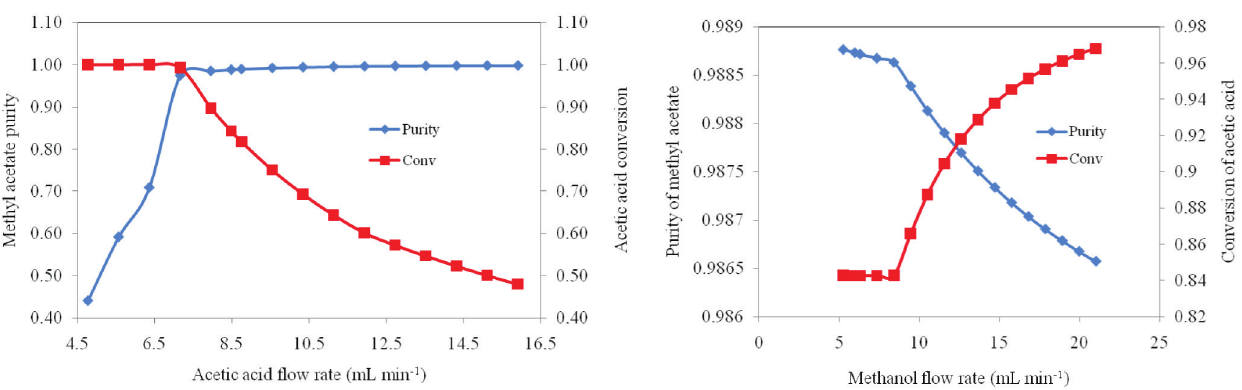
Fig. 12 – Effect of methanol feed flow rate on the methyl acetate purity and acetic acid